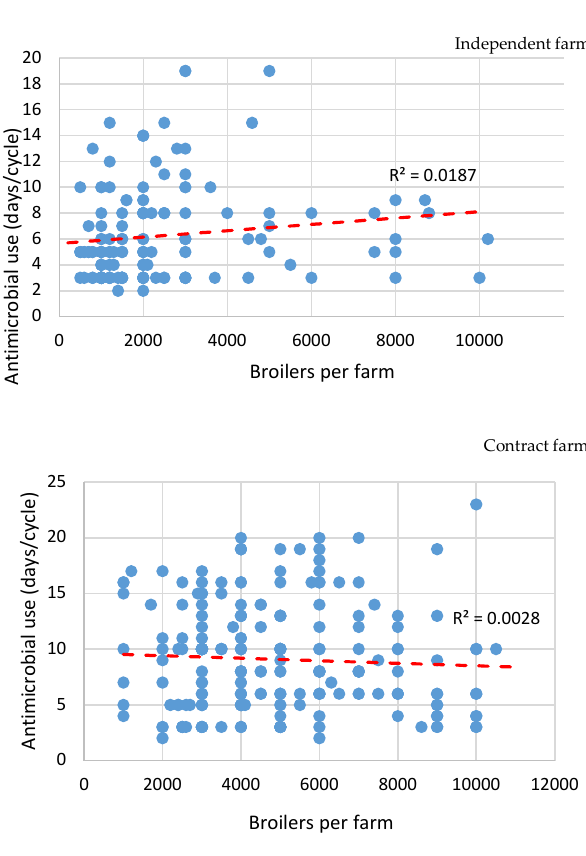
Figure 4. The correlation between number of days antibiotics given, farm size and management type (contract vs. independent).